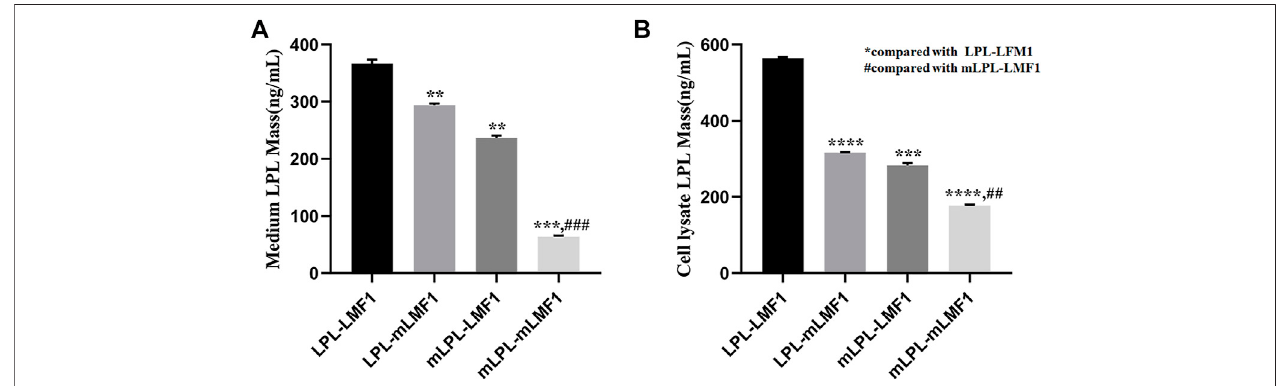
FIGURE4| LMF1andLPLdoublemutantssigni fi cantlydecreasedLPLlevels. (A) .The LMF1 and LPL genemutationbothcauseddecreaseofLPLlevelsinthecell medium. Thecombination of LMF1 and LPL gene mutation signi fi cantly decreasedLPL mass inthe cell medium (*compared toLPL-LMF1, #compared tomLPL-LMF1; **** p < 0.0001, ** p < 0.01). (B) . The LMF1 and LPL gene mutation caused decrease of LPL mass in the cell lysate. The combination of LMF1 and LPL gene mutation signi fi cantly decreased LPL mass in the cell lysate (*compared to LPL-LMF1, #compared to mLPL-LMF1; ## p < 0.01, *** p < 0.001, **** p <